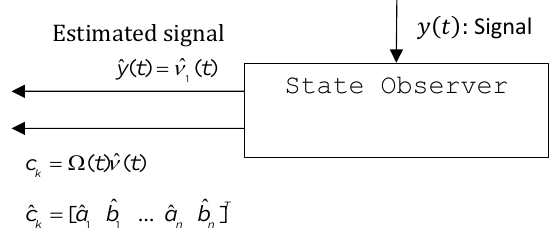
Figure 1. Schema of the reconstruction of a signal by using the spectral observer.